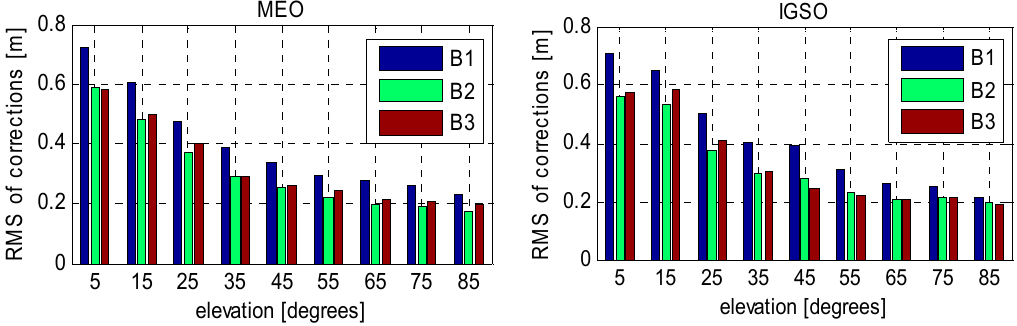
Figure 7. Suggested RMS of correction values (orbit type-, frequency-, and elevation-dependent). Table 2. Correction values and their precisions for BeiDou MEO/IGSO code measurements.